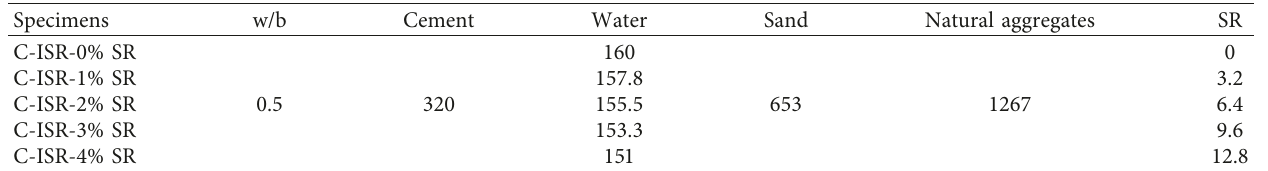
Table 2: Concrete mixture proportions (kg/m 3